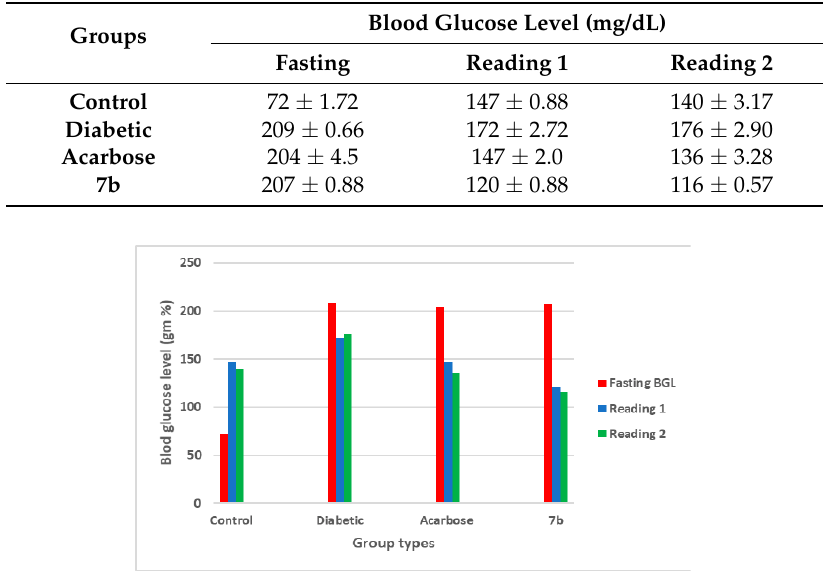
Figure 3. The bar chart of the effect of reference drug and target compound ( 7b ) on the blood glucose level in treated and non-treated